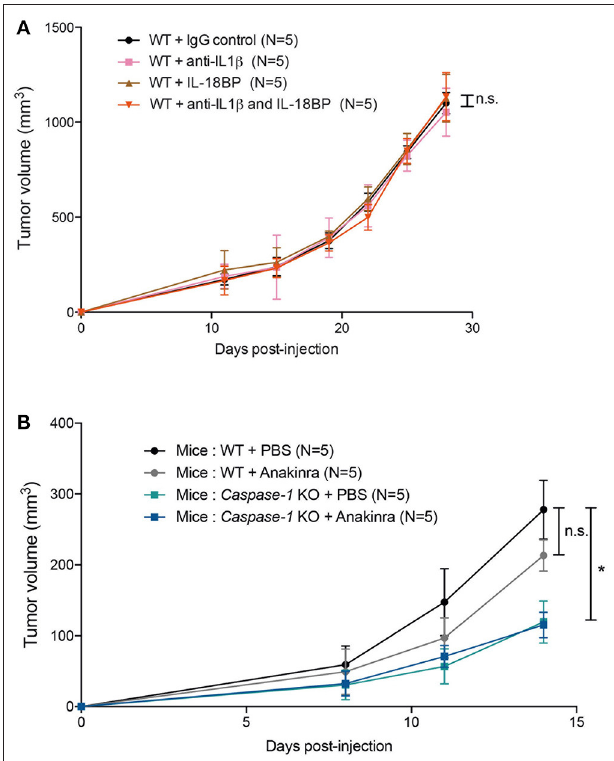
FIGURE 5 | IL-1 β , IL-18 or IL-1R inhibition does not affect 4T1 tumor growth in vivo . (A) WT ( n = 5) were injected with IgG control, anti-IL1 β antibody, IL-18BP, or both anti-IL1 β and IL-18BP the day before tumor inoculation and then every 3 days. Treated mice were orthotopically injected with 4T1 mammary tumor cells. Tumor growth was measured over 28 days. (B) WT, caspase-1 KO were injected with PBS or Anakinra (IL-1 receptor inhibitor) the day before tumor inoculation and then every 2 days. Treated mice were orthotopically injected with 4T1 mammary tumor cells. Tumor growth was measured over 14 days. Data represent mean ± SD * P < 0.05 (Two-way ANOVA analysis; n.s,